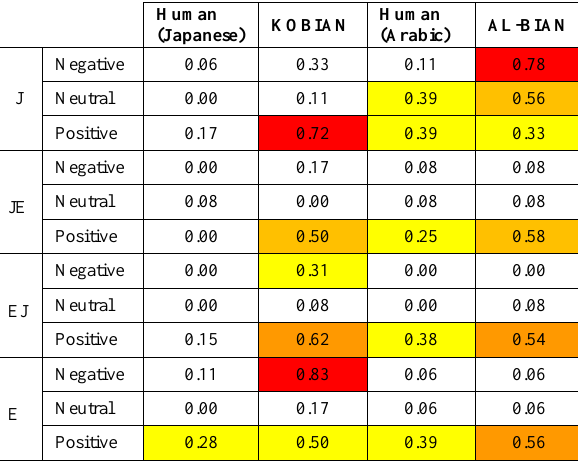
Table 5. Differences in preference of greeting compared to human operators.